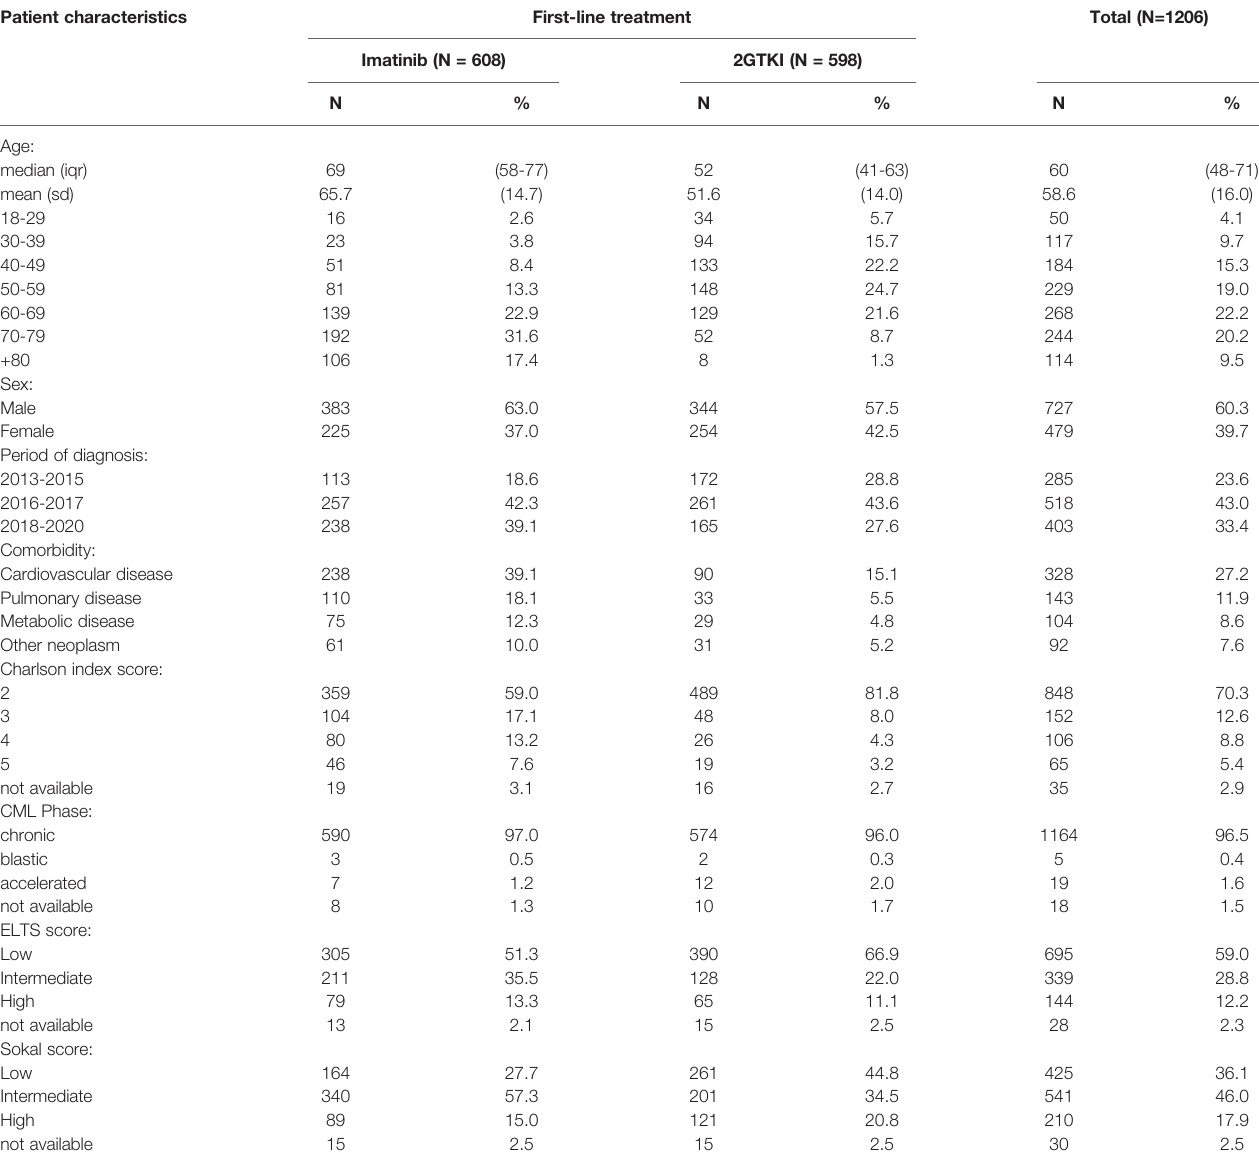
TABLE 1 | Baseline CML patient characteristics by front-line TKI treatment. Patient